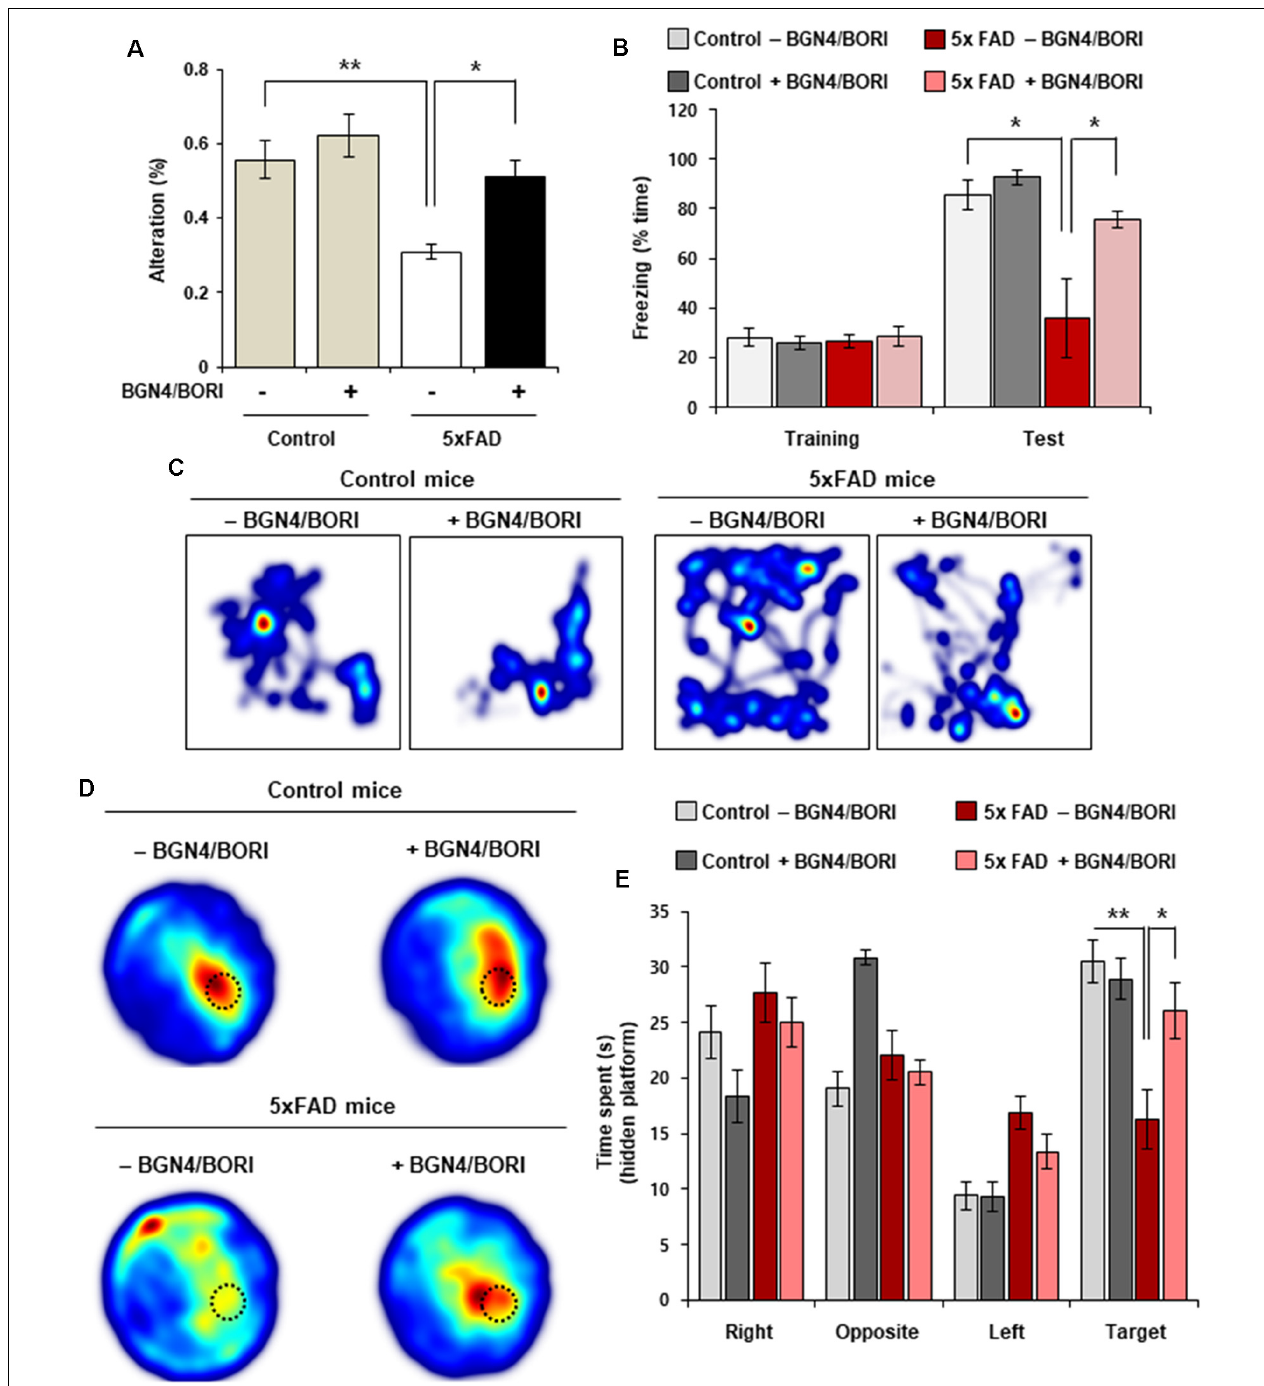
FIGURE 4 | Cognitive impairments was attenuated by B. bifidum BGN4 and B. longum BORI in 5xFAD Mice. (A) Effect of B. bifidum BGN4 and B. longum BORI (BGN4/BORI) treatment on the performance of control and 5xFAD mice in the Y-maze test. The percent spontaneous alternation was recorded over 5-min in each trial. Data represent the mean ± SEM. ANOVA , * p < 0.05, ** p < 0.01 ( n = 6 per group). (B) Effect of B. bifidum BGN4 and B. longum BORI treatment on contextual fear conditioning test. Freezing levels of control ( n = 5), BGN4/BORI-treated control ( n = 5), 5xFAD ( n = 5), and BGN4/BORI-treated 5xFAD ( n = 6) on day 2. Data represent the mean ± SEM. ANOVA , * p < 0.05. (C) Representative heatmaps during fear conditioning test. (D) Effect of B. bifidum BGN4 and B. longum BORI on the performance of control and 5xFAD mice in the Morris water maze. Representative heatmaps showing that the time spent in the circular pool to assess long-term spatial learning memory. The dotted circle indicates the target region. (E) Quantification of duration in the probe quadrant in the prove trial. Data represent the mean ± SEM. ANOVA , * p < 0.05, ** p < 0.01 ( n = 8 per each group).